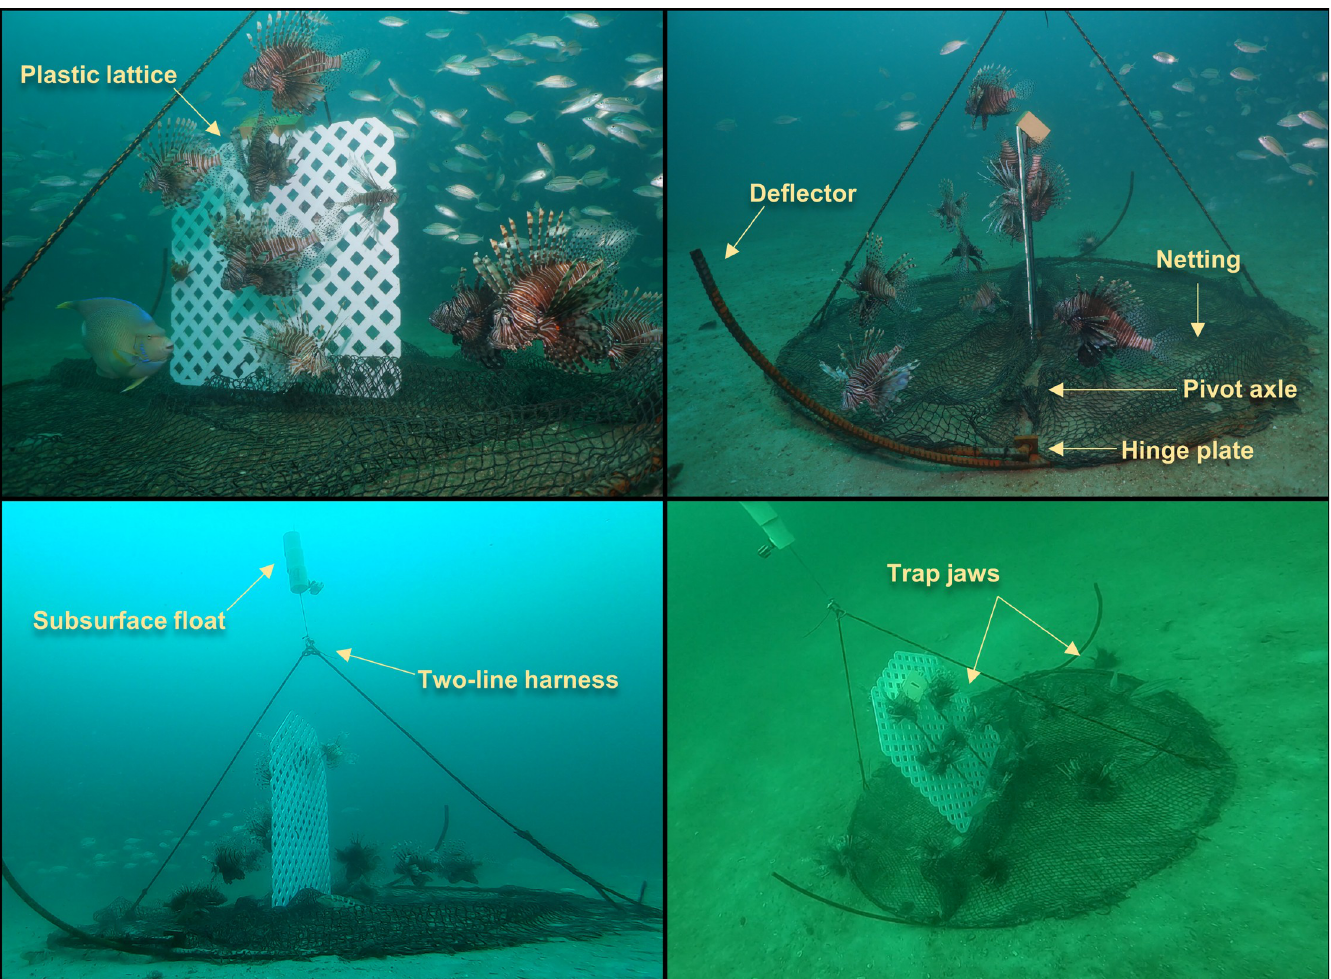
Fig 2. In water photos of a Gittings lionfish traps deployed near artificial reefs in the northern Gulf of Mexico. Lionfish are attracted to the structure made from plastic lattice. The trap jaws are constructed from rebar and bent to make deflectors that open the trap when it contacts the seafloor. The jaws open around a central pivot axle connected with a hinge plate. Fish are captured in the mesh nylon netting when the jaws are lifted via a two-line harness. Images: A. Fogg and H.